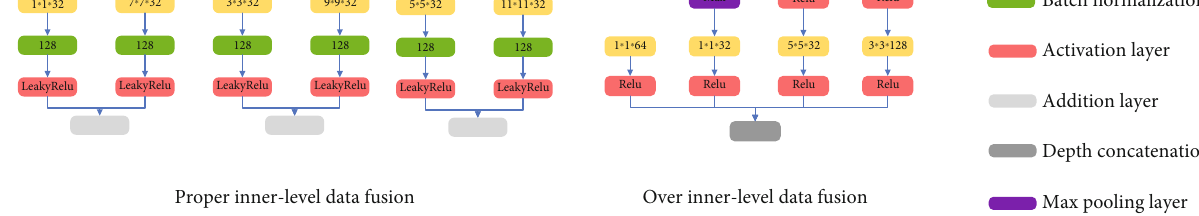
Figure 3: Proper net structure.